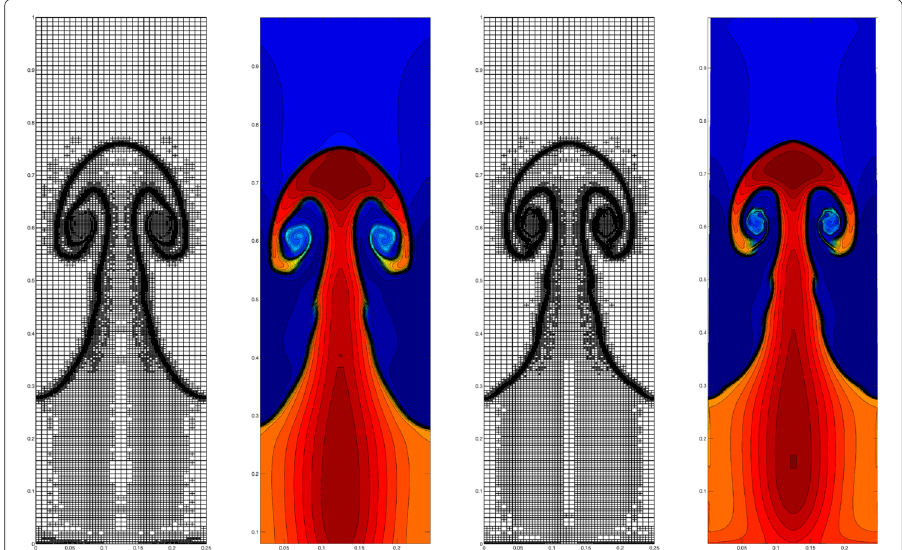
Fig. 15 NS simulations for Rayleigh-Taylor instability with Reynolds number Re ∞ = 150000. From left to right: adaptive mesh for P 1 element; 30 equally spaced density contours from 0.8608 to 2.2316 for P 1 element; adaptive mesh for P 2 element; 30 equally spaced density contours from 0.8712 to 2.2301 for P 2